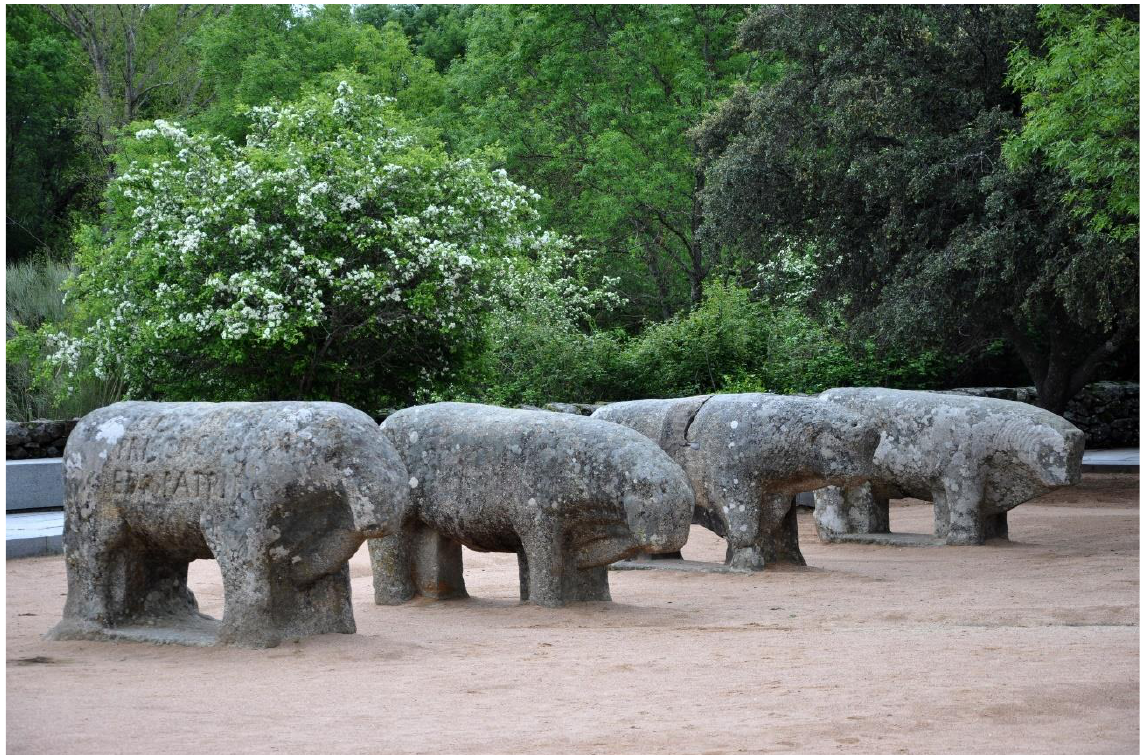
Figure 3. “Toros de Guisando” (El Tiemblo, Ávila), four Late Iron Age granite sculptures of more than 2.5 m in length representing bulls.